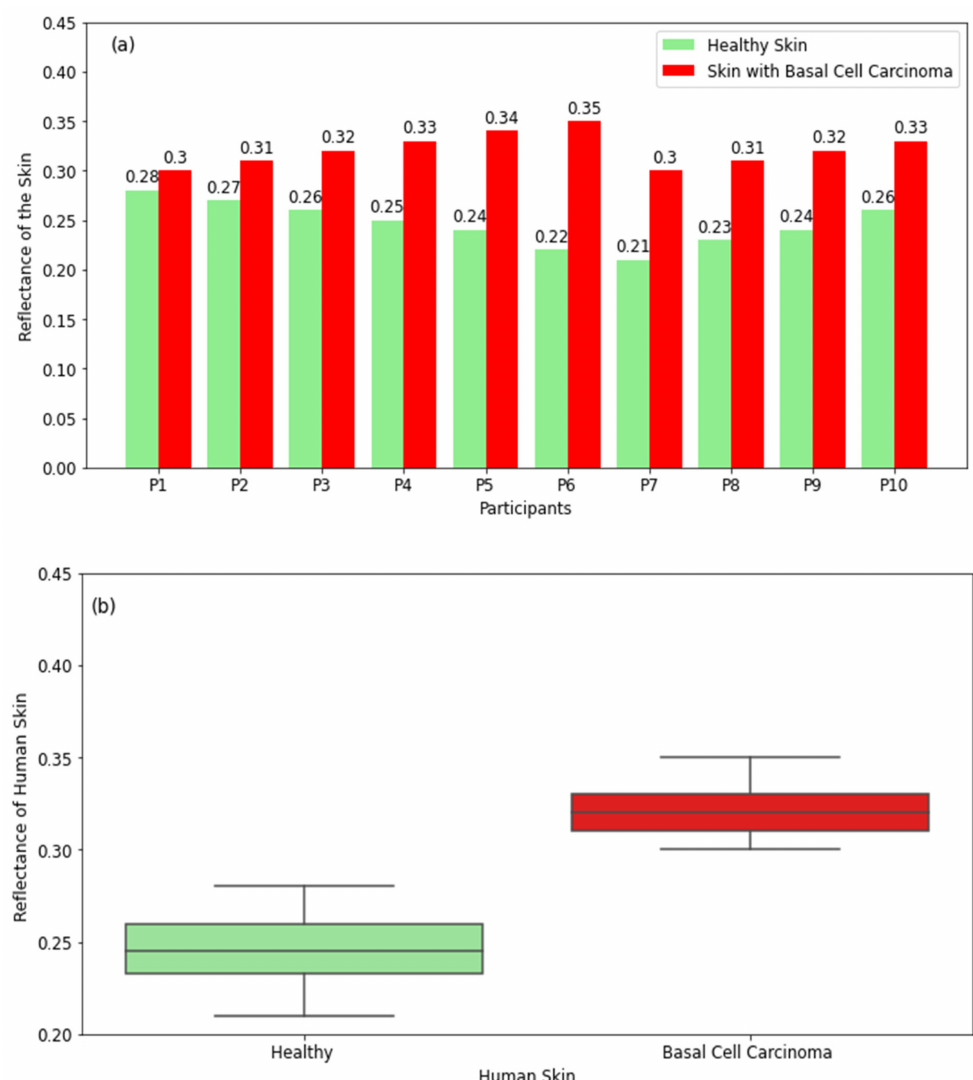
Figure 9. Reflectance measurements in a sample of 10 participants with basal cell carcinoma compared with the closest region of healthy skin on the same participant ( a ). The boxplot shows the range of the reflectance of healthy skin and basal cell carcinoma ( b